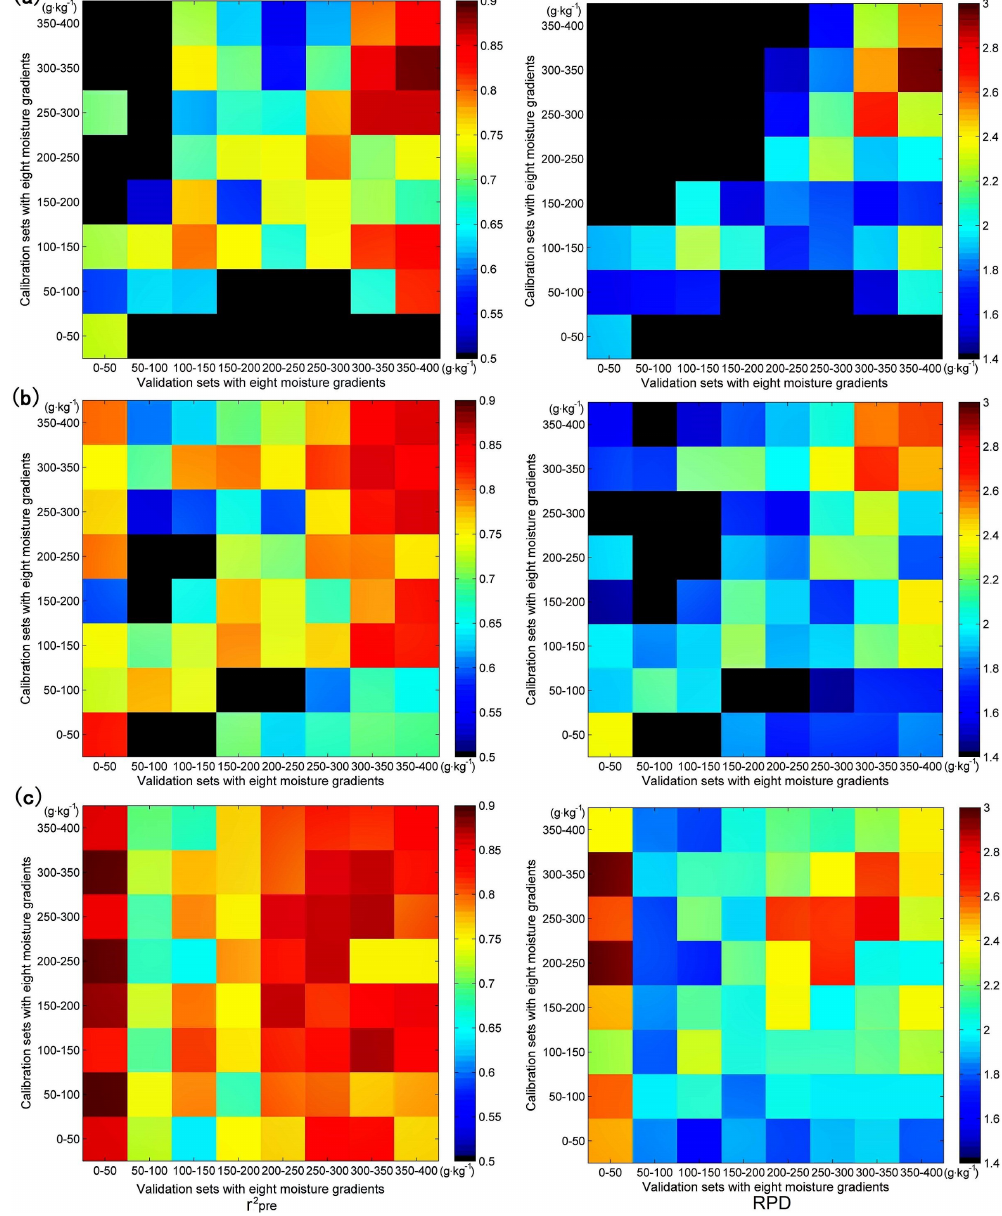
Figure 4. Coefficient of determination for prediction ( r 2 pre ) ( left ) and residual prediction deviation ( RPD ) ( right ) between the reference and predicted values in validation for the transferability of ( a ) PLSR; ( b ) OSC-PLSR; and ( c ) GLSW-PLSR models in the prediction of soil organic carbon (SOC) at different levels of moisture. PLSR, OSC-PLSR, and GLSW-PLSR models were calibrated partial least squares regression (PLSR) models according to the three spectral transformation strategies, namely, Savitzky-Golay (SG) smoothing, SG smoothing followed by orthogonal signal correction (OSC), and generalized least squares weighting (GLSW),